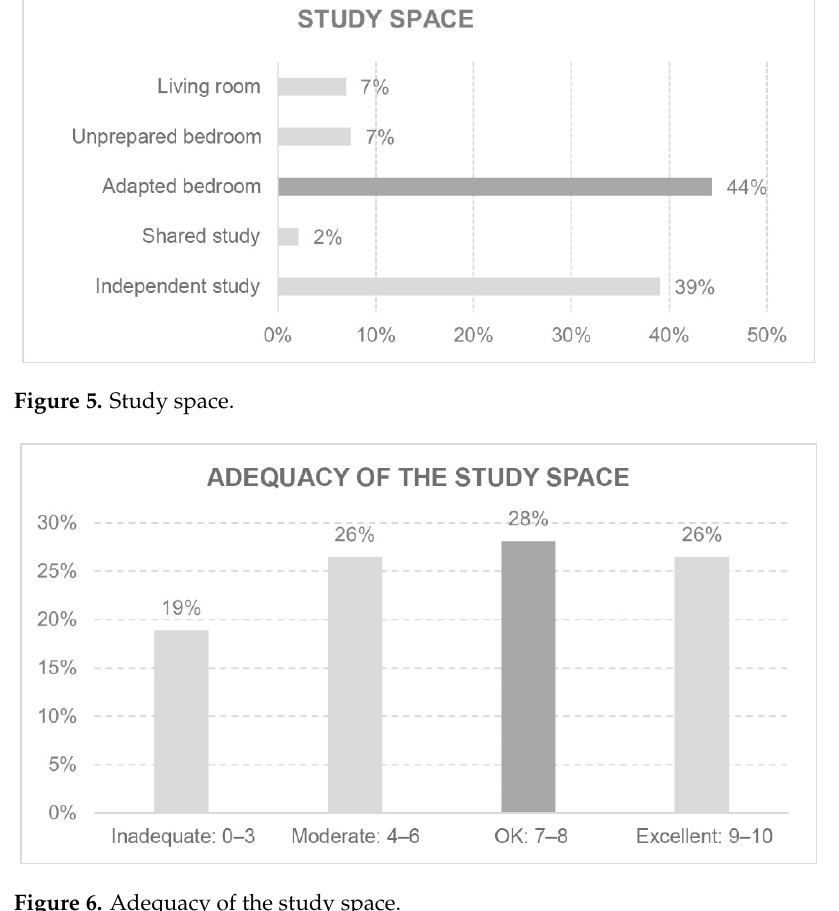
Figure 6. Adequacy of the study space.